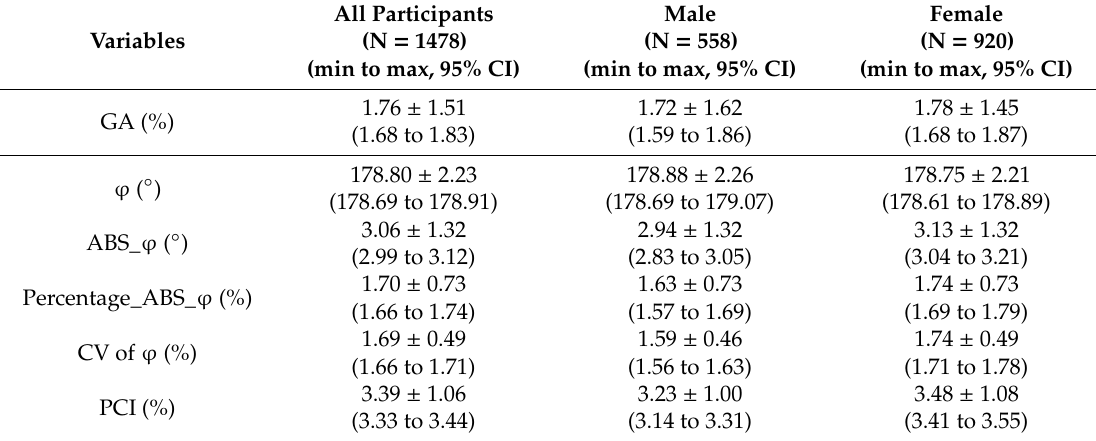
Table 4. Results of gait-related variables in healthy young adults: gait asymmetry (GA) and phase coordination index (PCI)